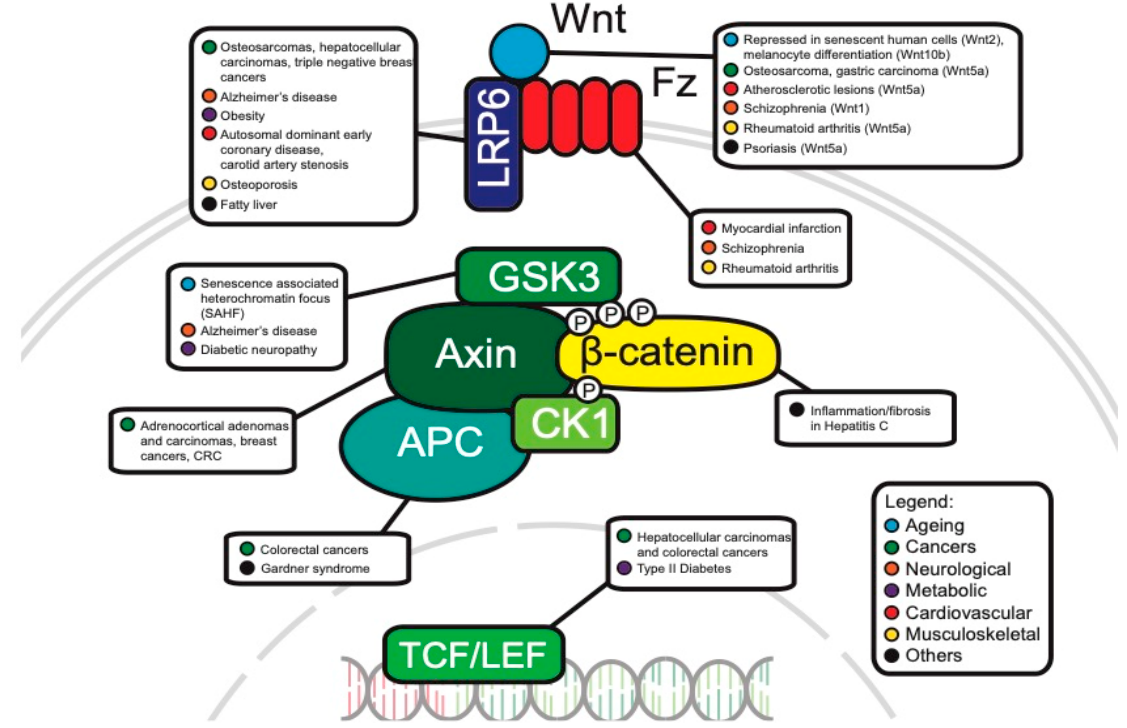
Figure 3. Canonical WNT pathway components associated with disease.